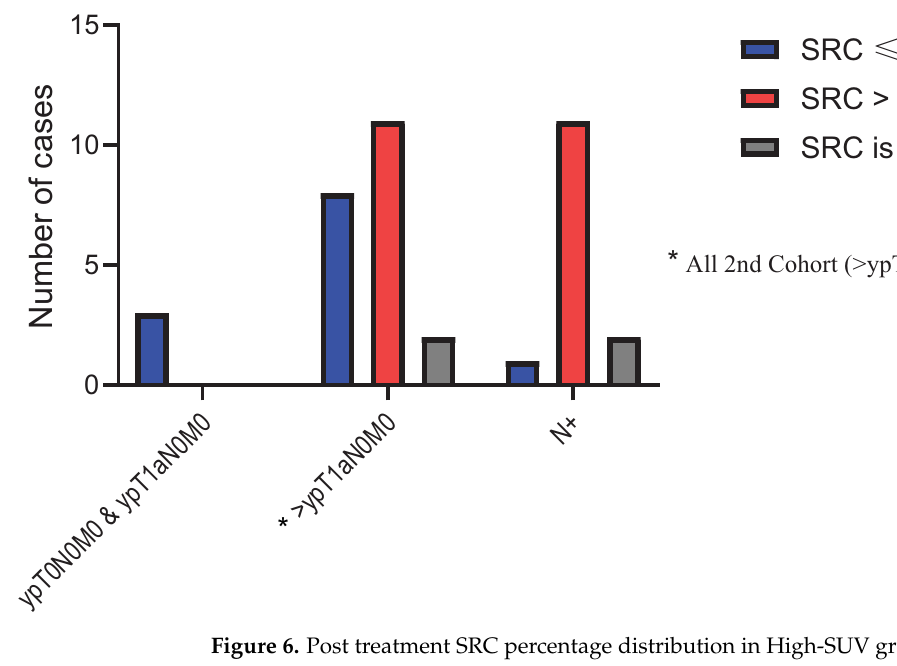
Figure 6. Post treatment SRC percentage distribution in High-SUV